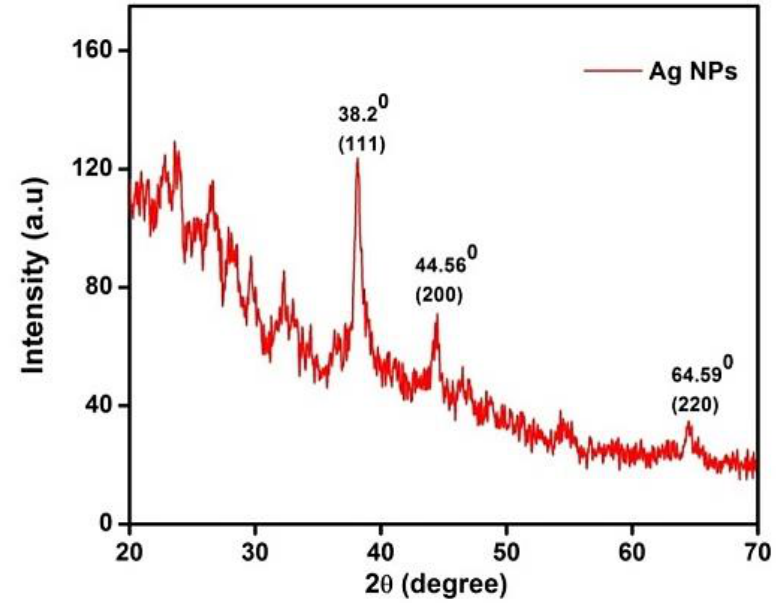
Figure. 1. XRD diffractogram of Chitosan mediated AgNPs